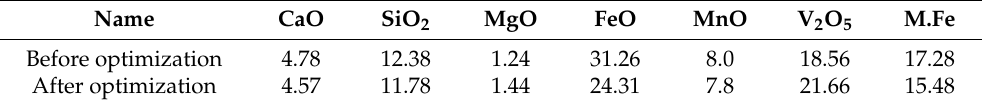
Table 7. Changes of vanadium slag composition before and after process